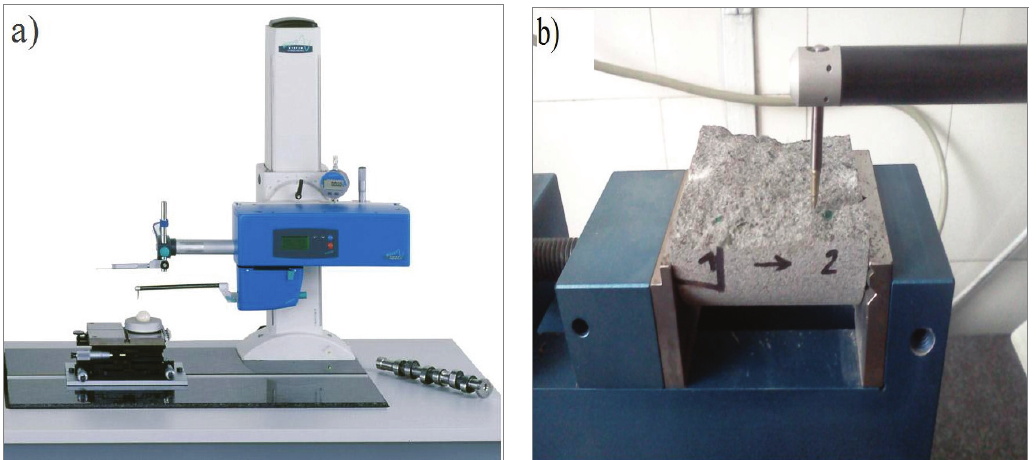
Fig. 3. (a) Contact profilometer Hommel Tester 8000 produced by Hommel Werke; (b) The rock sample mounted on a profilometer